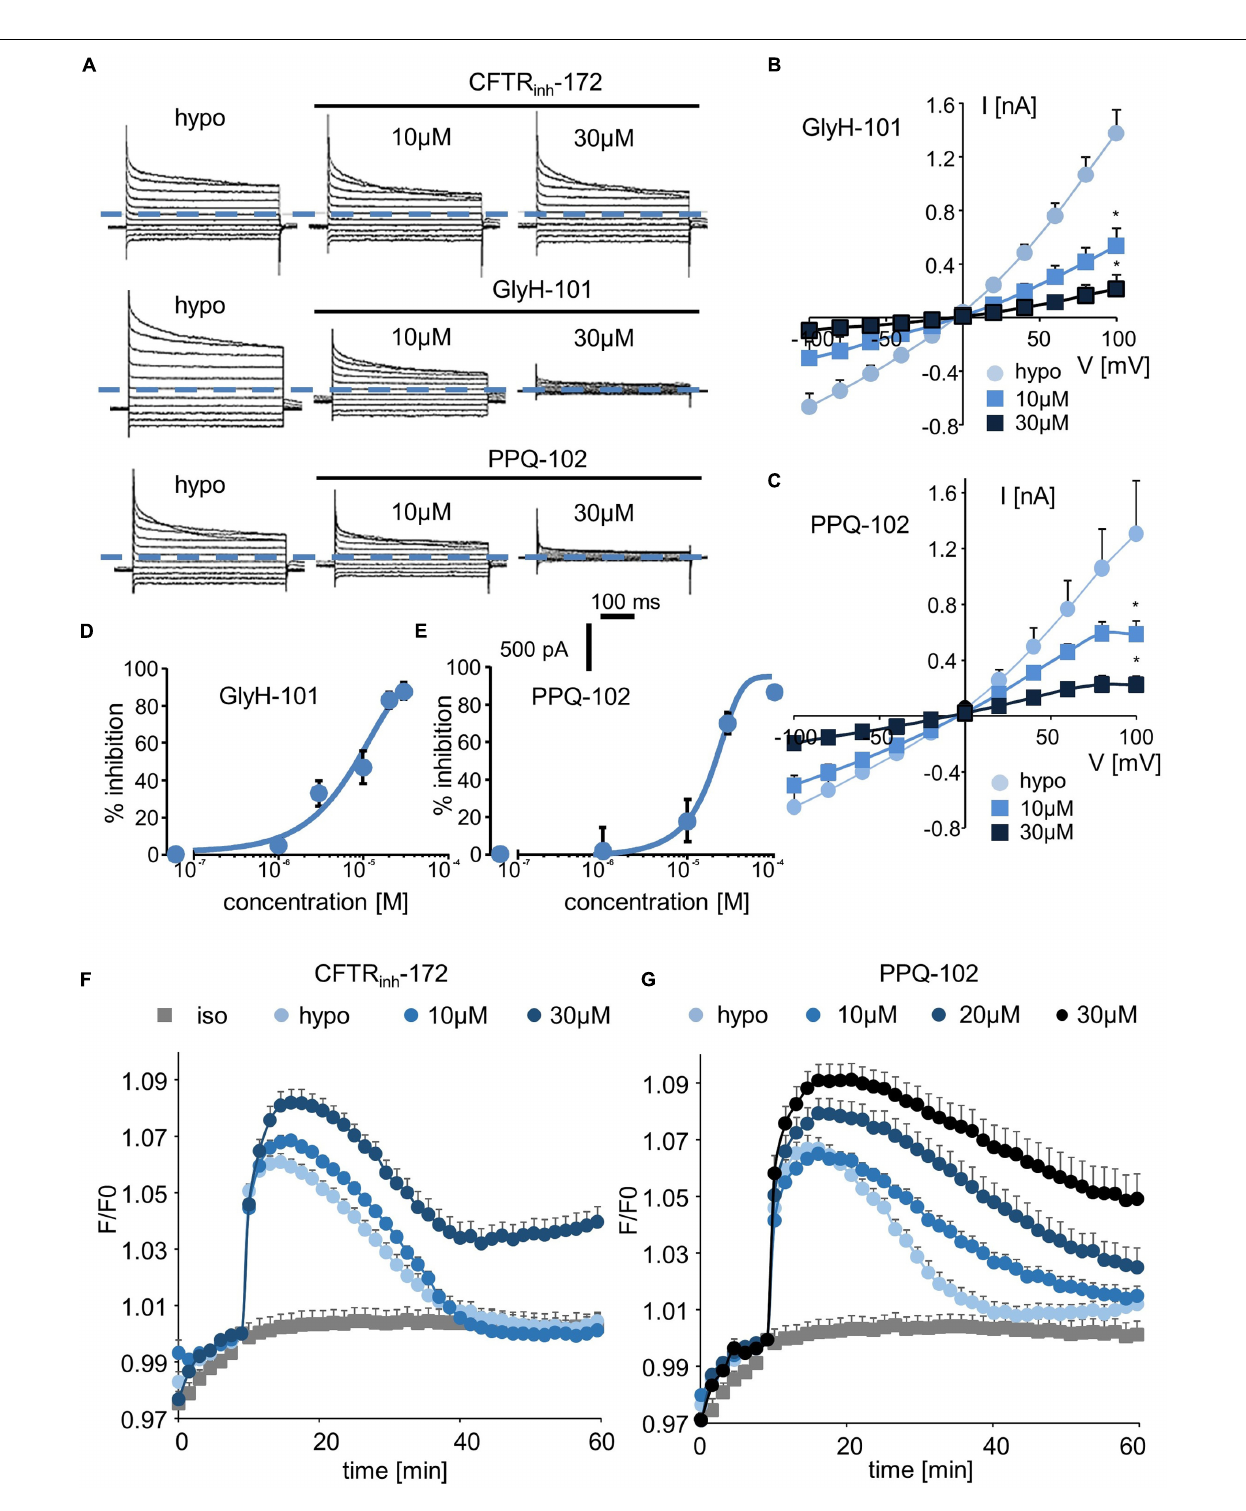
FIGURE 4 | Effect of CFTR inhibitors (CFTR inh -172, GlyH-101, and PPQ-102) on I Cl , swell and on the RVD process. (A–C) Whole-cell I Cl , swell inhibition induced by CFTR inh -172 at 10 and 30 µ M, GlyH-101 at 10 and 30 µ M, PPQ-102 at 10 and 30 µ M (A) and relative IV curves (B,C) . (D,E) Inhibition concentration curves permitting IC 50 calculation for PPQ-102 and GlyH-101. The reported values are the mean ± SEM of 5 individual records obtained for each experimental concentration and each inhibitor. (F,G) Inhibition by CFTR inh -172 (10 µ M, n = 10; 20 µ M, n = 10) and PPQ-102 (10 µ M, n = 12; 30 µ M, n = 8) of RVD following 100 mOsm.l − 1 hypotonic challenge based on calcein relative